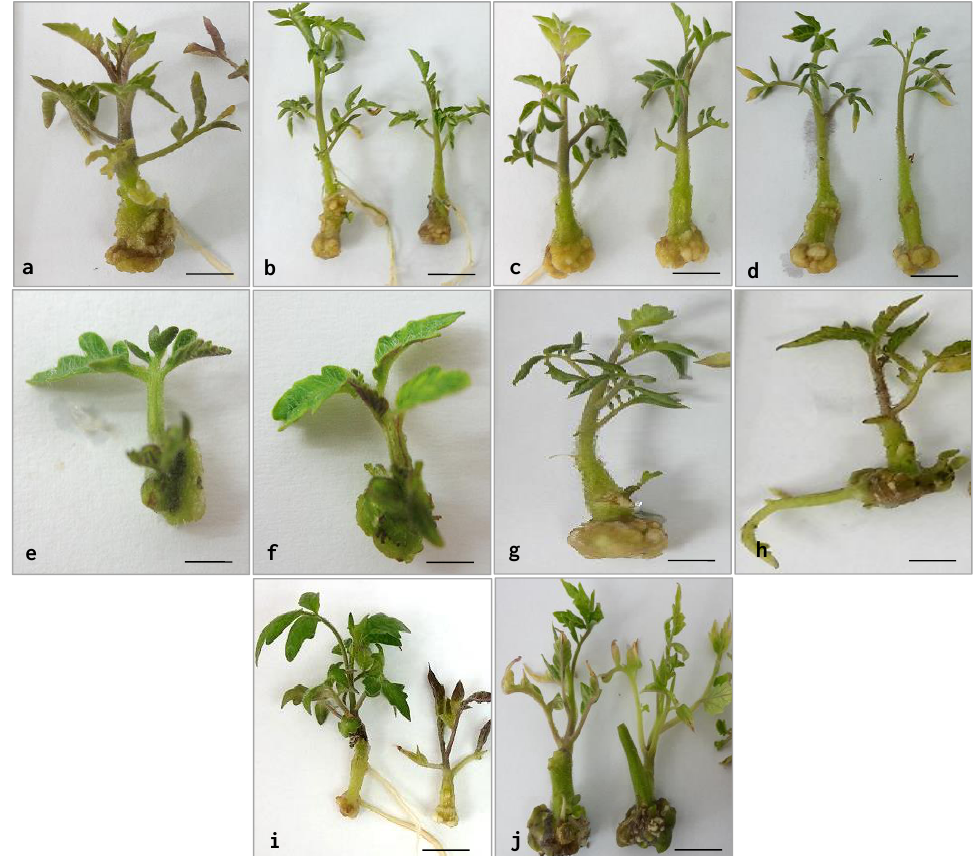
Figure 6. Callus development on culture media with different cytokinins. ( a ) cv. ‘Capriciu’ apical bud (V1); ( b ) cv. ‘Capriciu’ stem node (V1); ( c ) cv. ‘Darsirius’ apical bud (V2); ( d ) cv. ‘Darsirius’ stem node (V2); ( e ) cv. ‘Kristin’ apical bud (V4); ( f ) cv. ‘Kristin’ stem node (V4); ( g ) cv. ‘Pontica’ apical bud (V4); ( h ) cv. ‘Pontica’ stem node (V4); ( i ) cv. ‘Siriana’ apical bud (V3); ( j ) cv. ‘Siriana’ stem node (V3). Bars 1 cm.